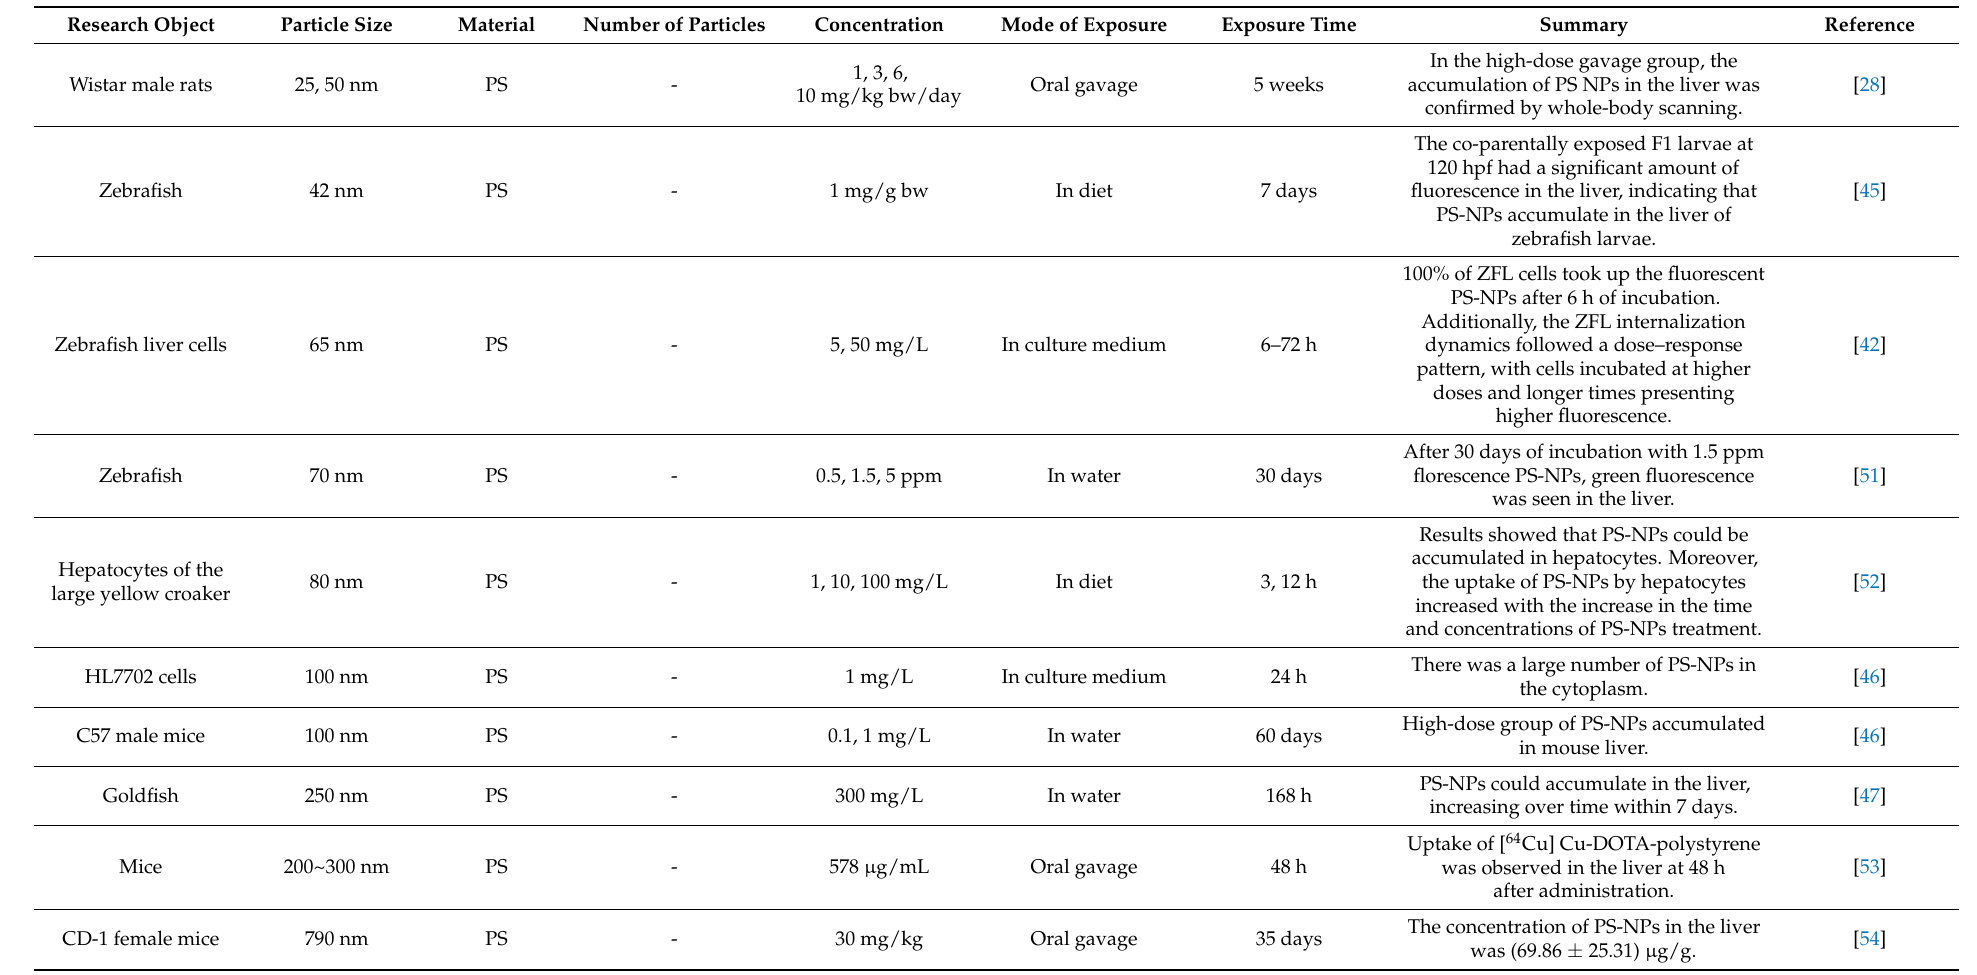
Table 1. The study parameters and effects of accumulation of NPs in the